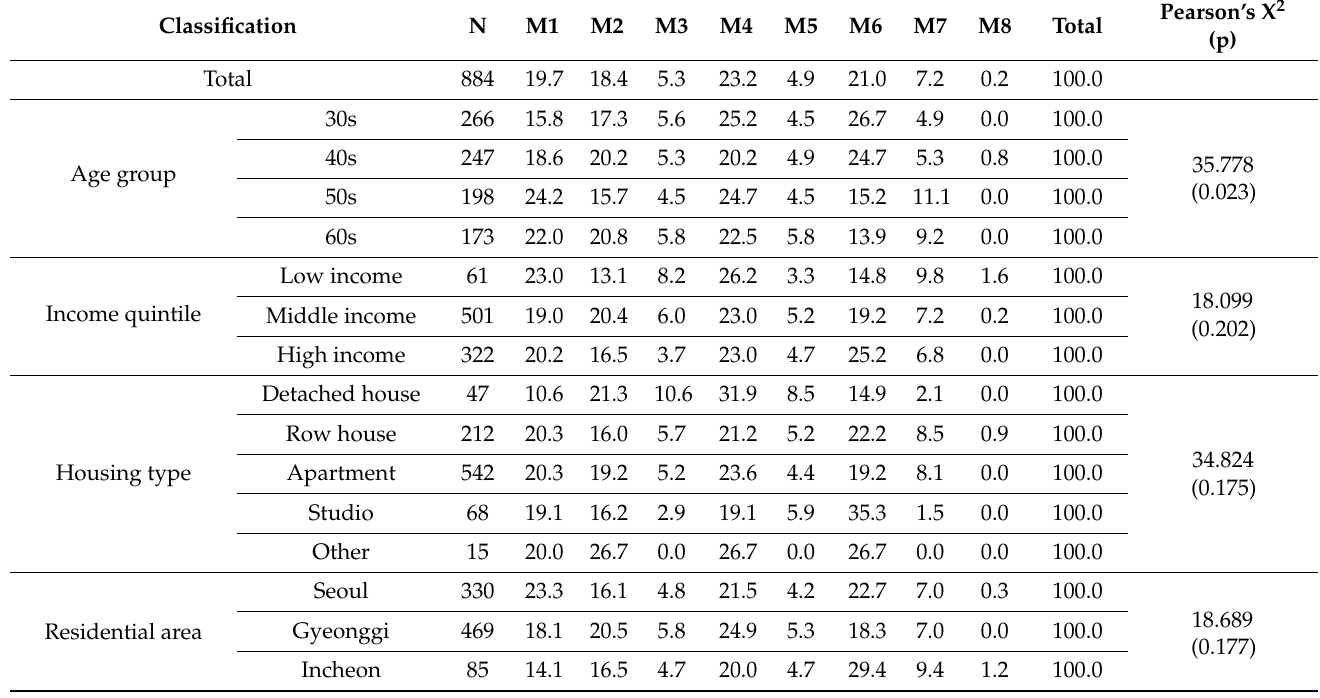
Table 10. Significant factors for the maintenance and management of street trees and cross-analysis of